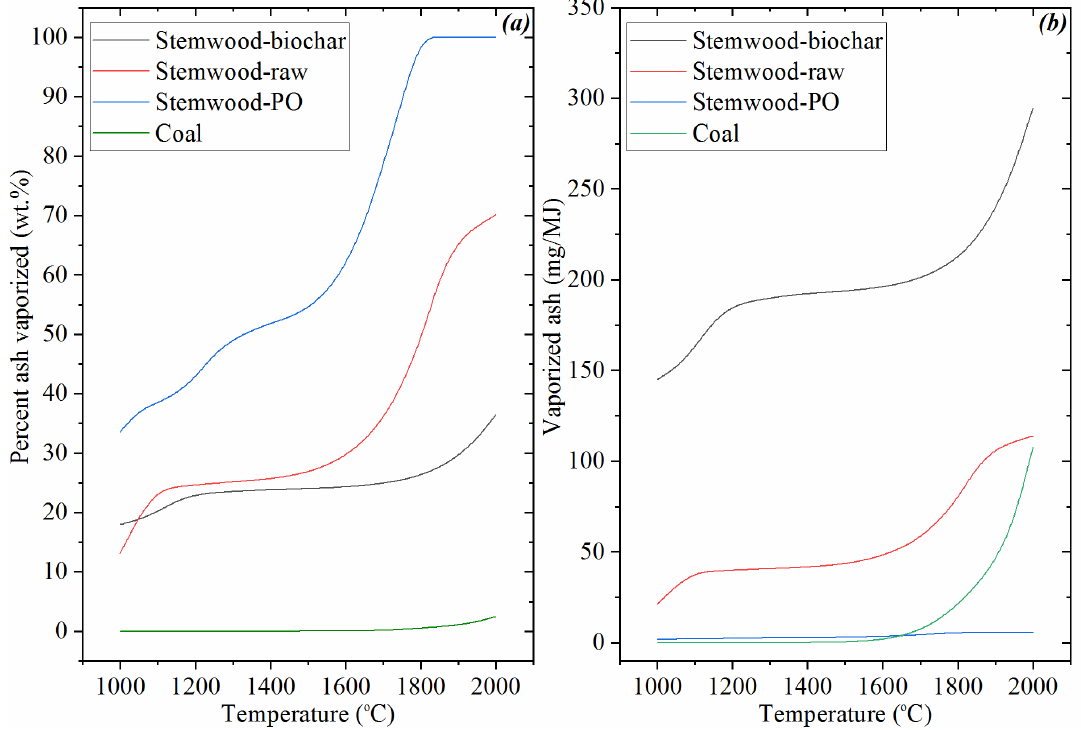
Figure 12. ( a ) Percent ash vaporized (wt.%); ( b ) the total amount of vaporized ash (mg/MJ).